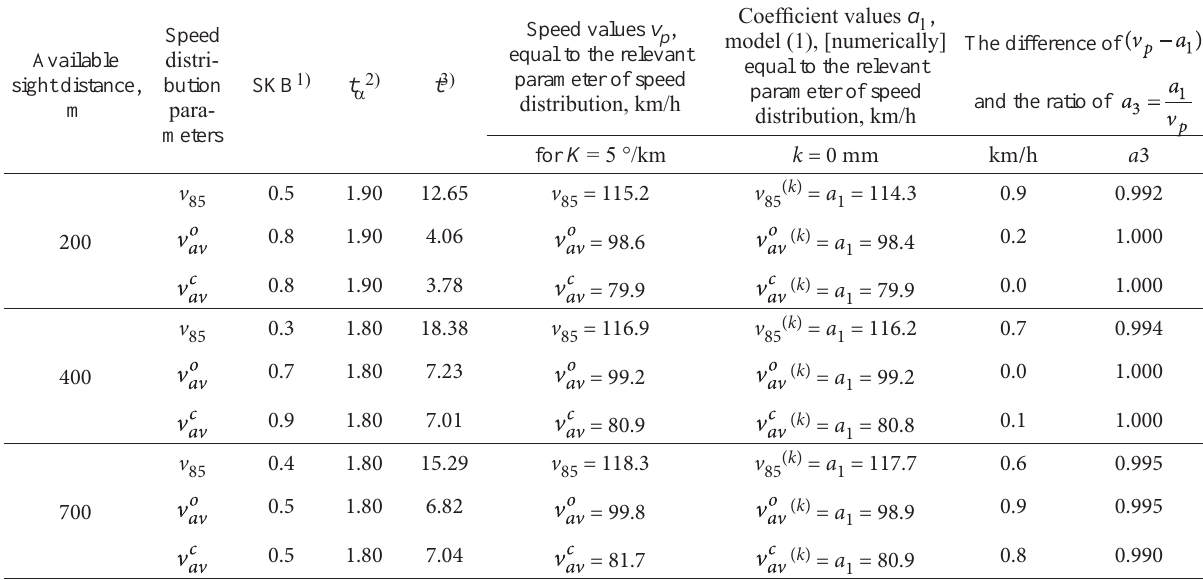
Table 3. Speed values v p and coefficient values a 1 , by model (1), at the available sight distances and for k = 0 mm (Sołowczuk 2005)